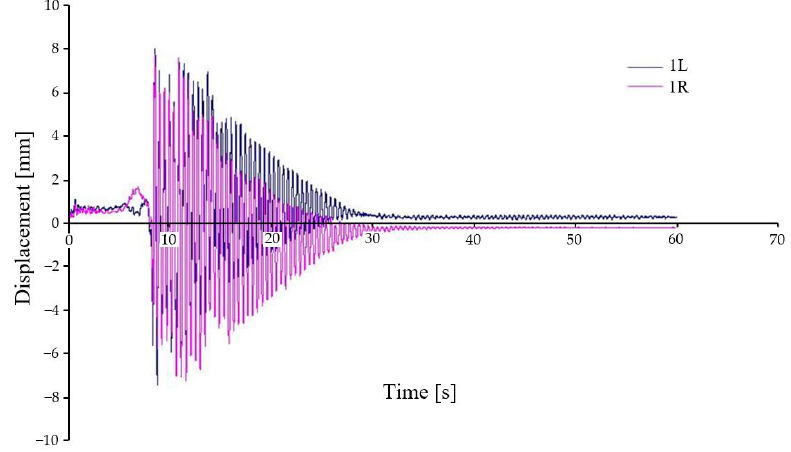
Figure 14. Relative displacement between chassis frame and wheelset—variant D-I.